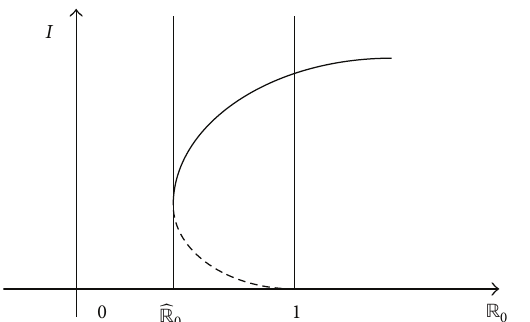
Figure 4: A backward bifurcation at R 0 = 1 with a dashed curve for the location of the saddle point and solid curve for the location of the other endemic equilibria.